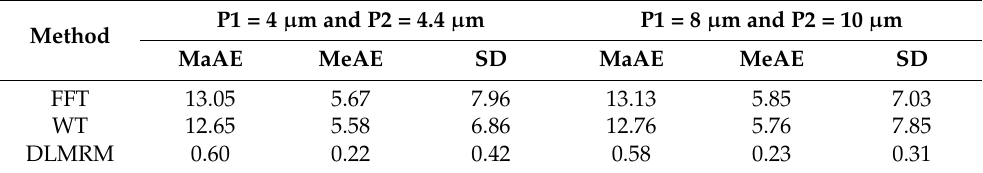
Figure 11. Deep learning-based bias regression measurement network framework. Table 1. Error comparison between deep-learning-based bias regression measurement strategy and classical algorithms.